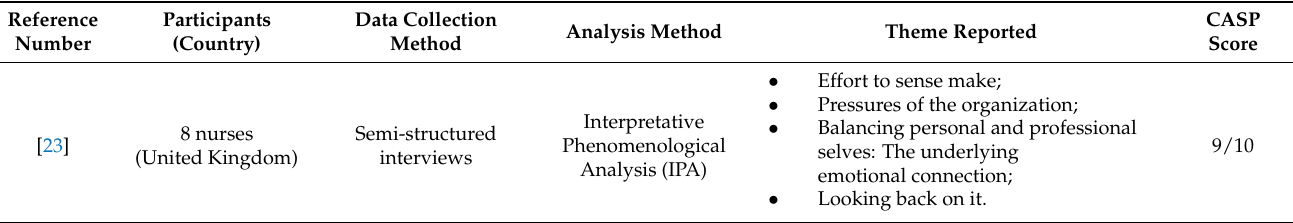
Table 1. Summary of the included